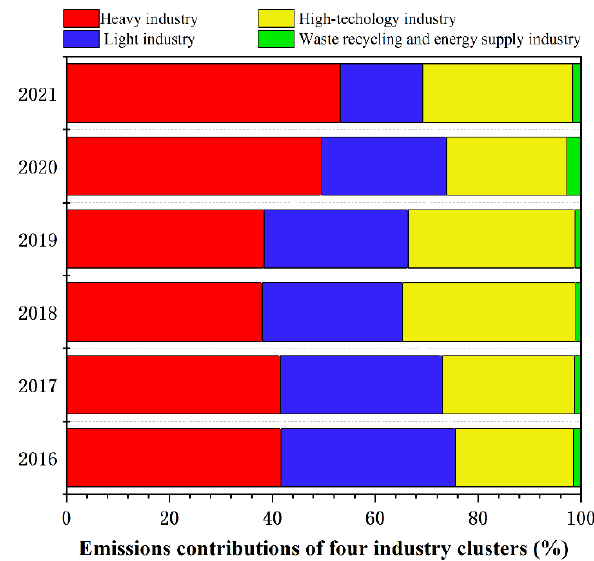
Figure 5. CO 2 emissions contribution rates of four industry clusters from 2016 to